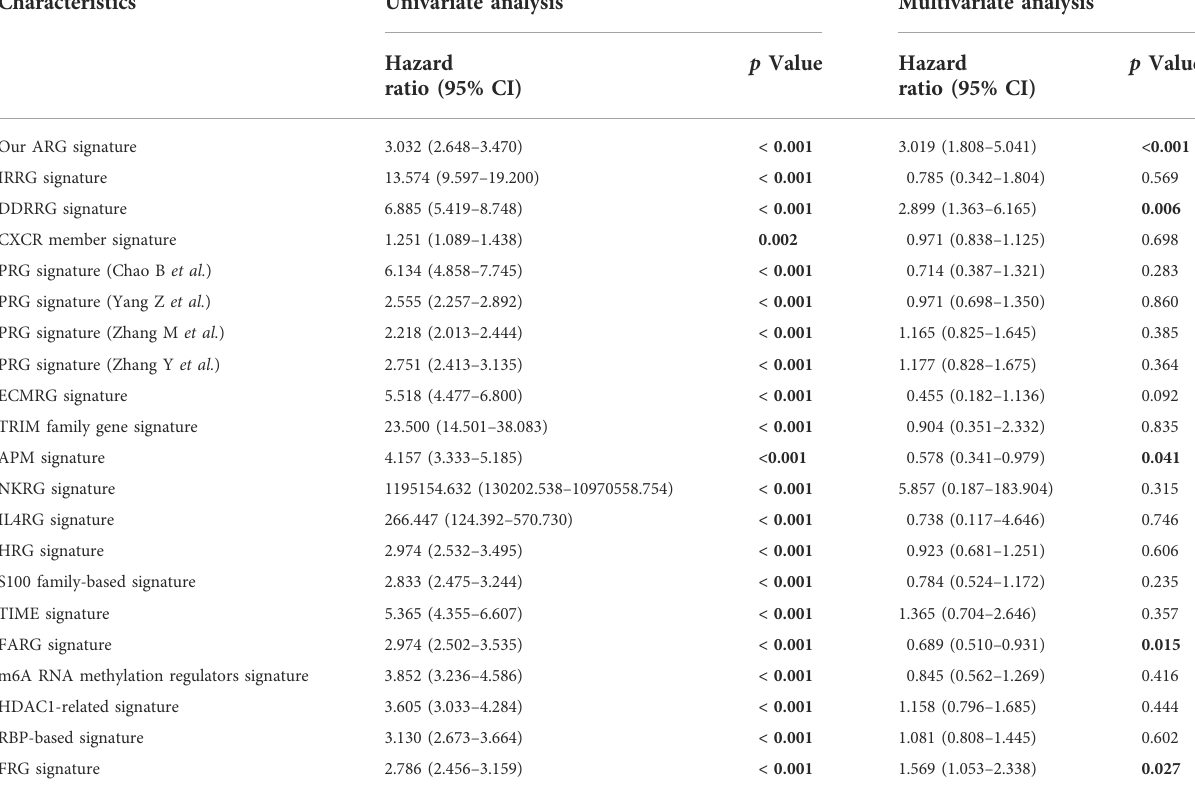
TABLE 1 Univariate and multivariate Cox regression analyses of different risk